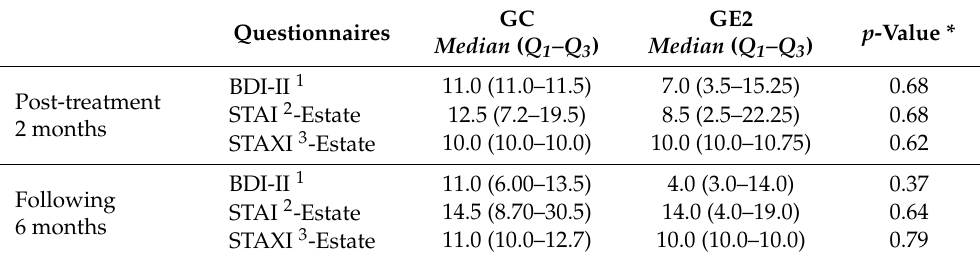
Table 3. Median comparisons between post-treatment and following non-smokers from GC and GE2.